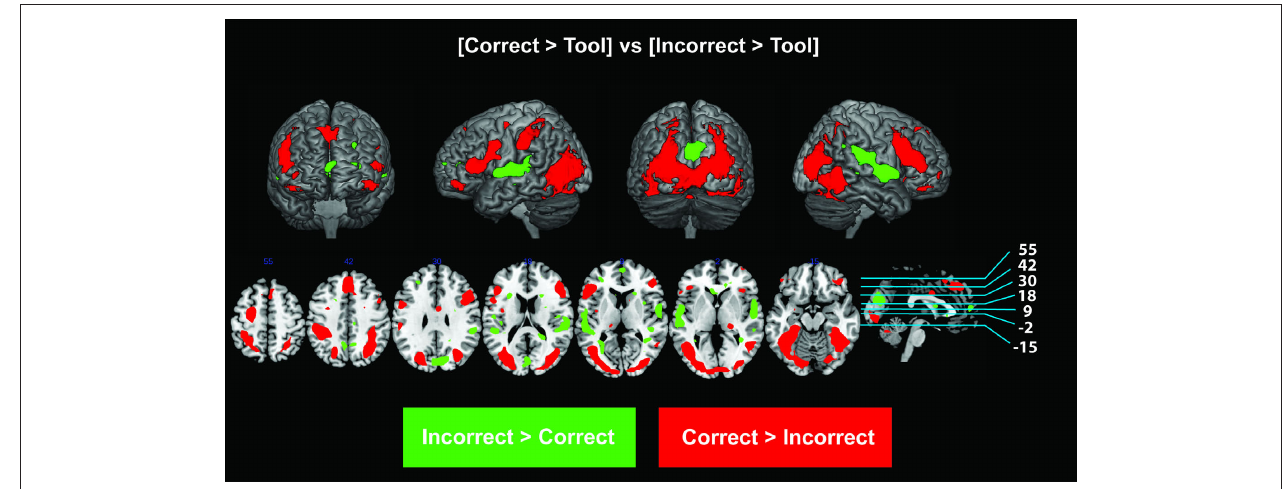
green. All activations shown were statistically significant at an FDR corrected P < 0.05. Slice images are also presented below surface renderings, and slice orientations are shown to the right of each series of